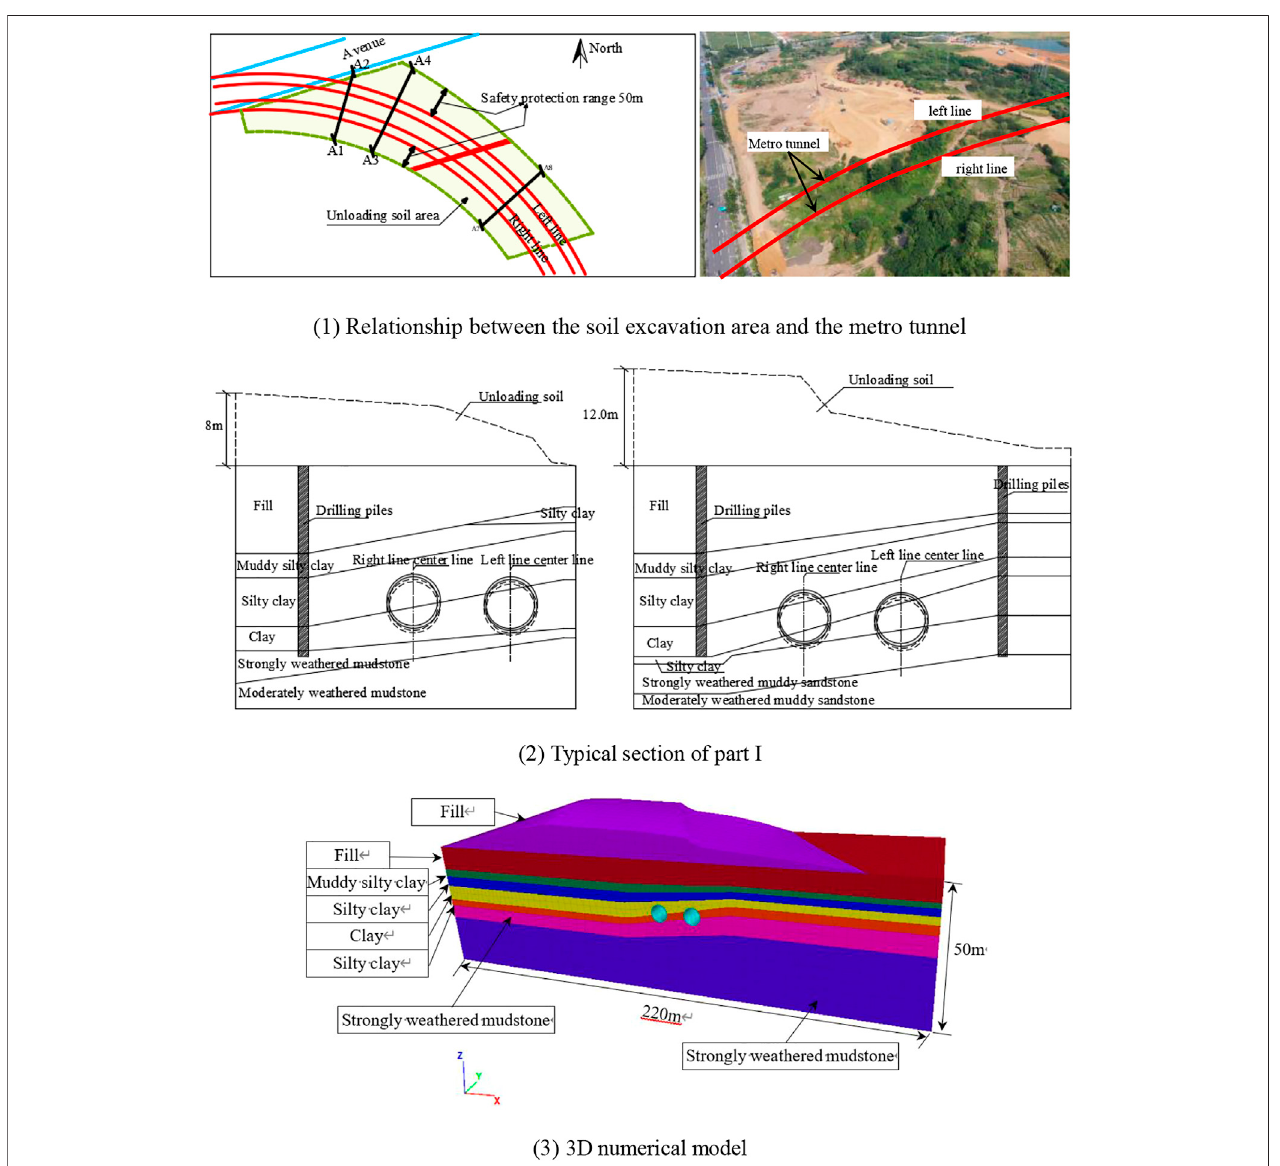
FIGURE 10 | Numerical modeling process.